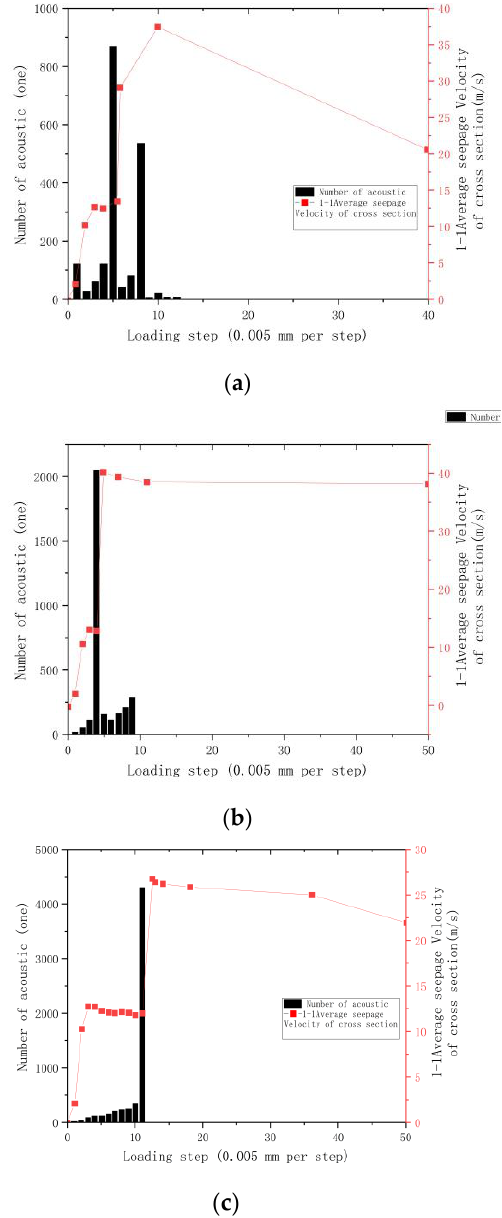
Figure 9. Numerical load step-stress-acoustic emission curve. ( a ) Prefabricated weak surface model. ( b ) Prefabricated weak zone model. ( c ) Complete model.